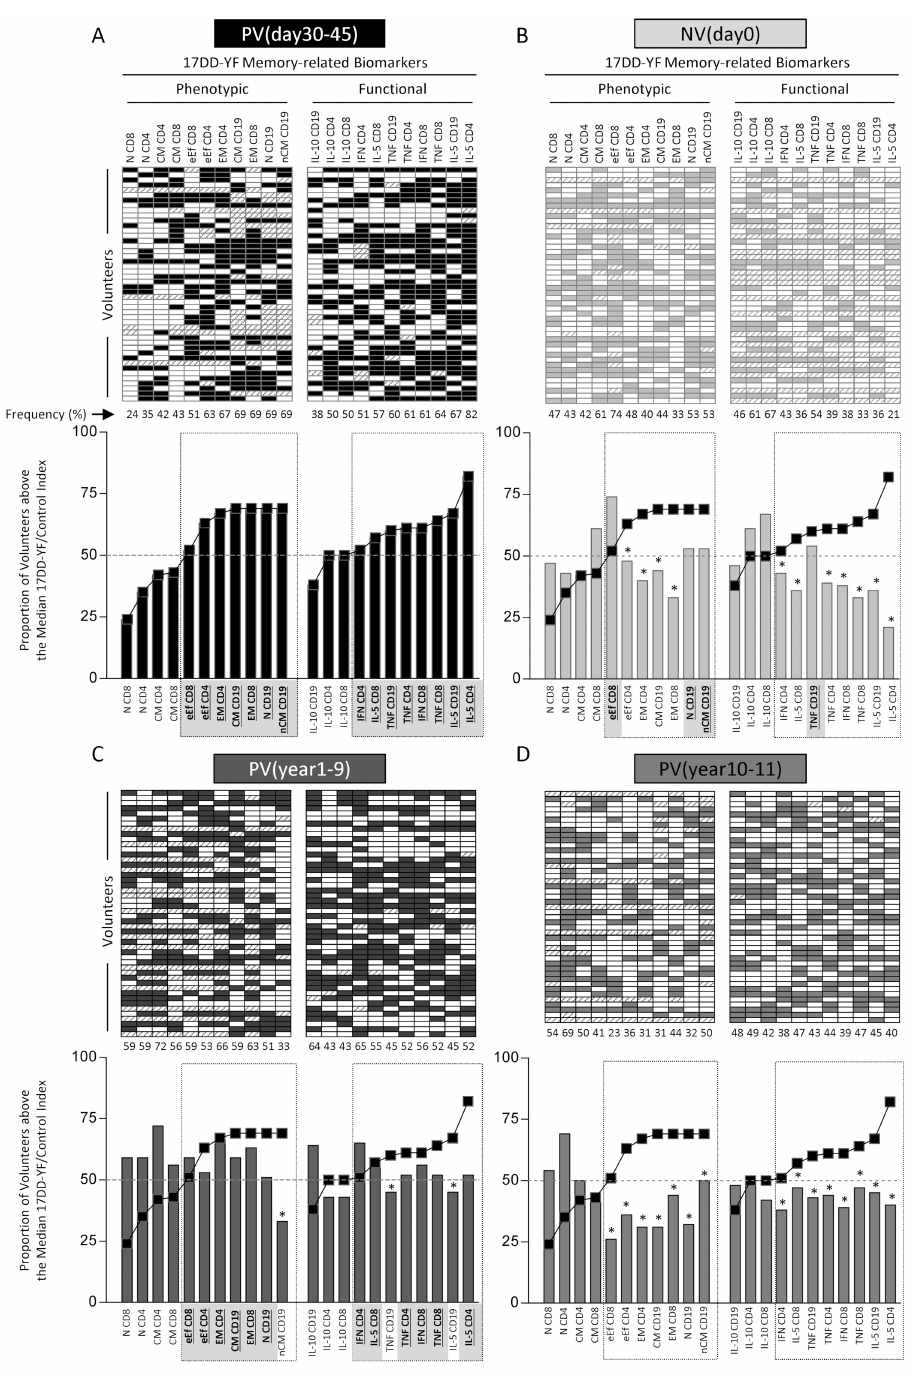
Fig 1. Overall 17DD-YF memory-related biomarker signatures at distinct time-points after primary vaccination. The phenotypic/functional biomarker signatures were built taking the proportion of subjects above the cut-off edges defined for each attribute, calculated as the median index value (17DD-YF/Control) for the study population. Diagrams were constructed for all study groups to calculate the proportion (%) of volunteers above the median cut-off indices for each biomarker (gray-shaded spots). (A) The PV(day30-45) group was used to construct the memory- related phenotypic and functional biomarker signatures and draw the reference curves, used for comparative analysis amongst the study groups, (B) NV(day0), (C) PV(year1-9) and (D) PV(year10-11). Hatched cells represent unavailable results. Data mining was carried out as proposed previously by Luiza-Silva et al., (2011), selecting from the